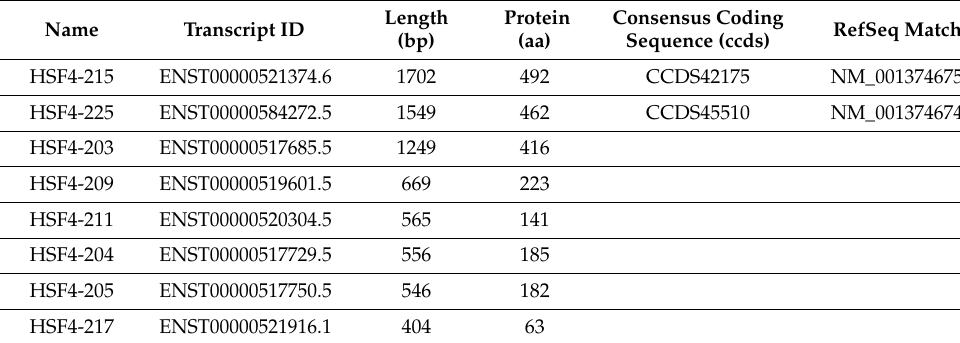
Table 1. List of annotated HSF4 protein-coding transcripts. The data were retrieved from Ensembl data using human assembly